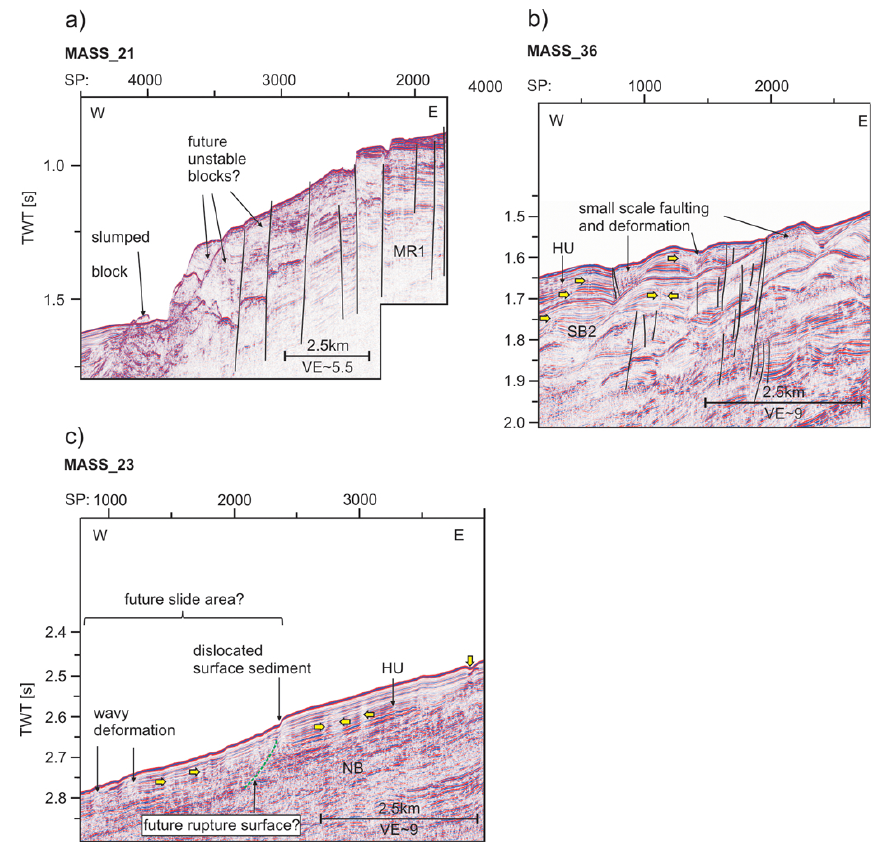
Fig. 8. Possible locations of future slope failures from the Mergui Ridge setting (MASS 23), the East Andaman Basin in the southern working area (MASS 36) and the East Andaman Basin in the northern working area. (a) Seismic profile from the edge of Mergui Ridge located slightly south of MTDs D1 and D2. Several faults, marked by black lines, cut to the surface and indicate recent deformation and dislocation of blocks. A small slumped block may indicate that some failure already occured. (b) Profile MASS 36 shows drift sediments from the southern working area. Fluid migration pathways are imaged in these sediments as transparent narrow vertical zones (yellow arrows). Small scale faulting and deformation of the upper sedimentary layers may indicate future failure of the drift deposits. (c) Seismic profile MASS 23 reveals numerous vertical transparent features interpreted as pathways for fluids (yellow arrows), and a fault dislocating the sea floor (green dotted line), that might act as future rupture surface. Wavy deformation of the surficial sediments downslope of this fault may indicate remobilization of the sediment. See Figs. 2 and 3 for location of profiles, and text for further